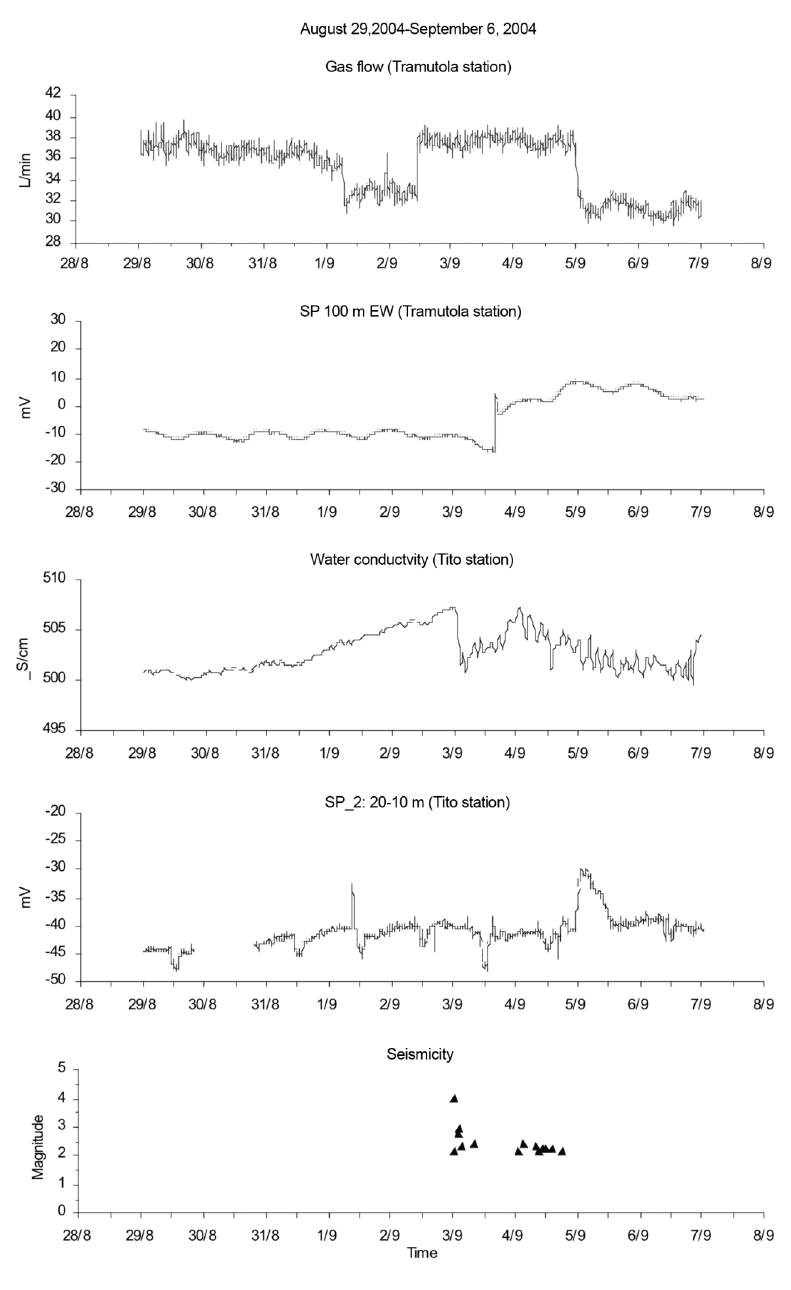
Fig. 9. Zoom on gas flow, SP and electrical conductivity signals recorded at the Tramutola and Tito stations and the local seismicity between August 29, to September 6, 2004. An anomalous behaviour in both locations were recorded before and after the seismic